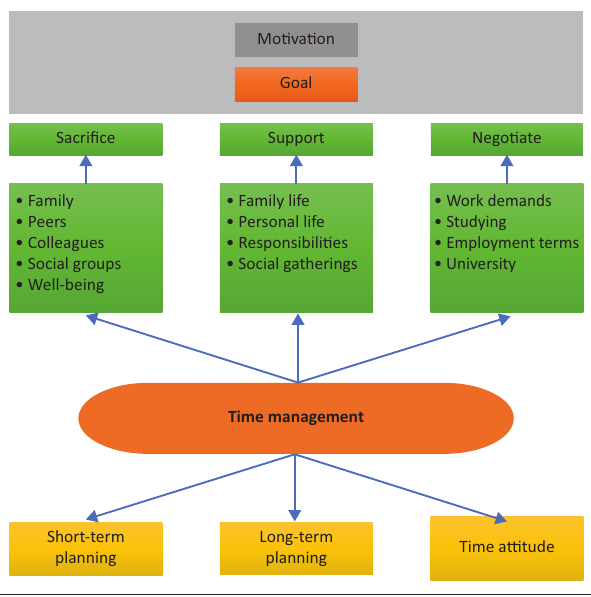
FIGURE 1: Proposed work–study–life demands coping mechanism model.